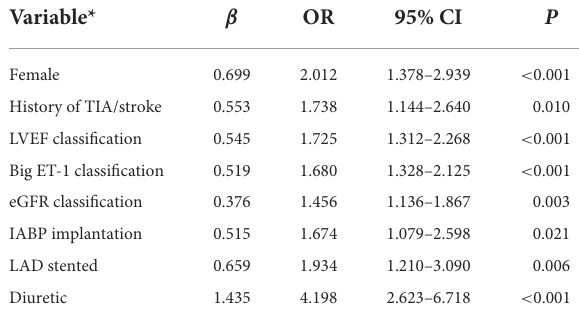
TABLE 2 Multivariable logistic analysis for CI-AKI.